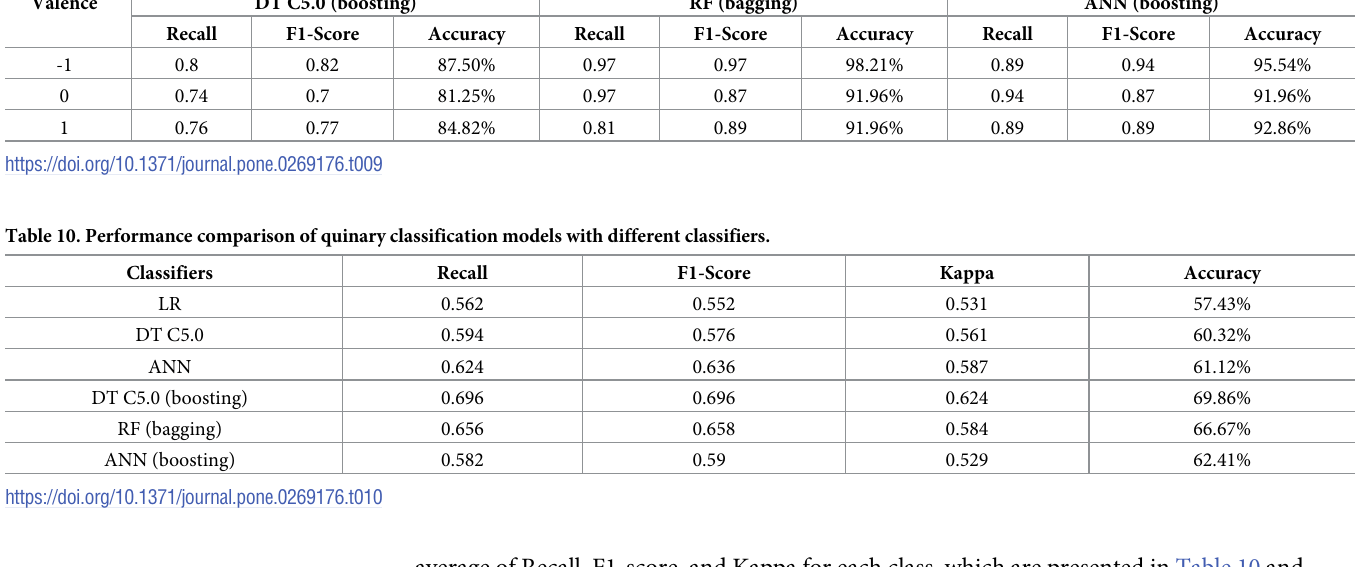
average of Recall, F1-score, and Kappa for each class, which are presented in Table 10 and Fig 8. The performance indices of each class classification in the quinary classification model are listed in Tables 11 and 12. The results of the quinary classification indicated that the model that incorporated DT C5.0 (boosting) had the best classification performance. However, its accuracy was only 69.86%, and the kappa coefficient was low, which demonstrated that the recognition performance of